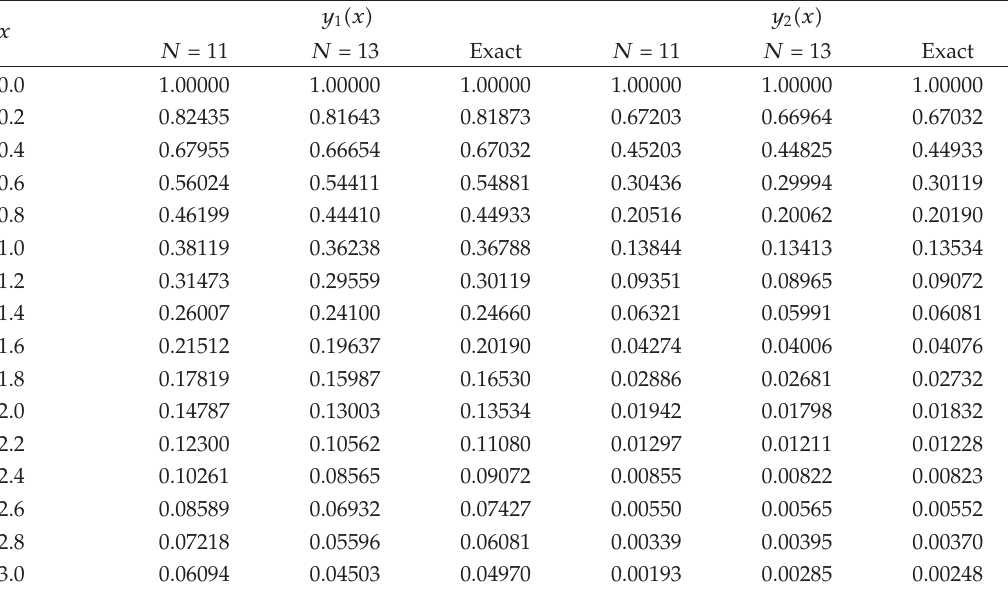
Table 1: Numerical results of Example